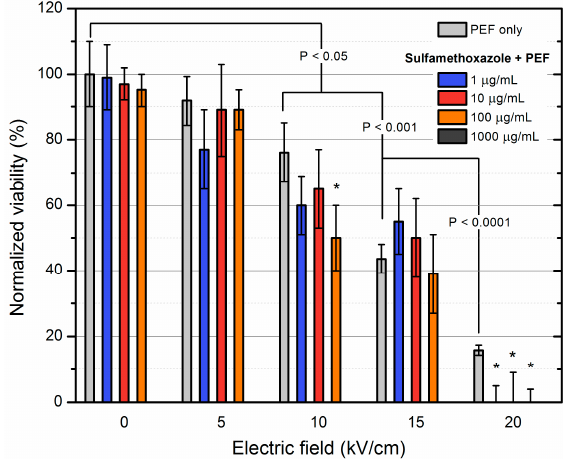
sulfamethoxazole of varied concentration. Asterisk (*) represents statistically significant ( p < 0.05) difference versus only pulsed electric field (PEF) treatment. Statistically significant ( p < 0.05) additive effect with PEF was observed during the 20 kV/cm